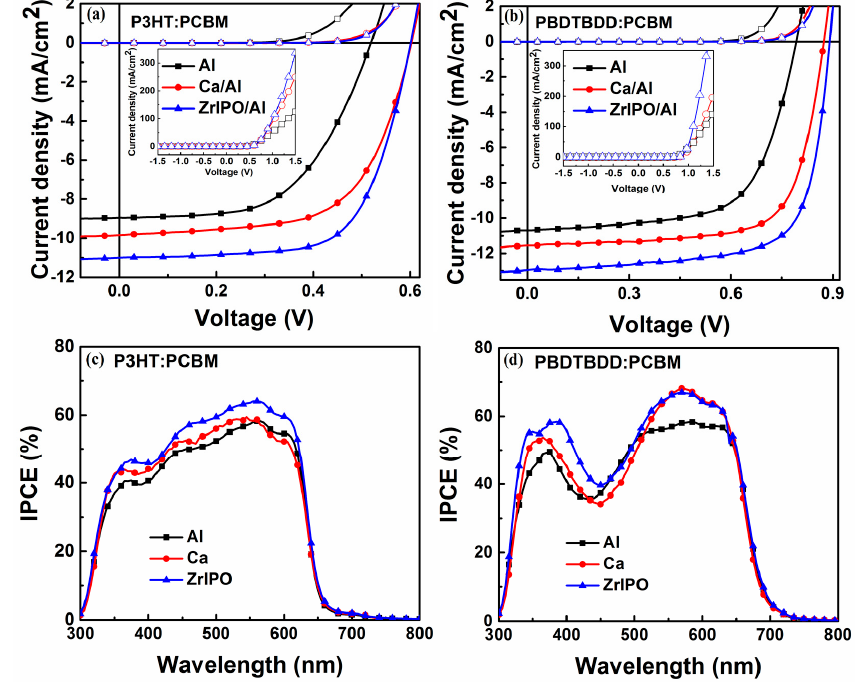
Figure 5. J – V curves of the PSCs based on ( a ) P3HT:PCBM and ( b ) PBDTBDD:PCBM under the dark condition and under the illumination of AM1.5G, 100 mW/cm 2 ; Input photon to converted current efficiency (IPCE) spectra of the PSCs based on ( c ) P3HT:PCBM; ( d ) PBDTBDD:PCBM.